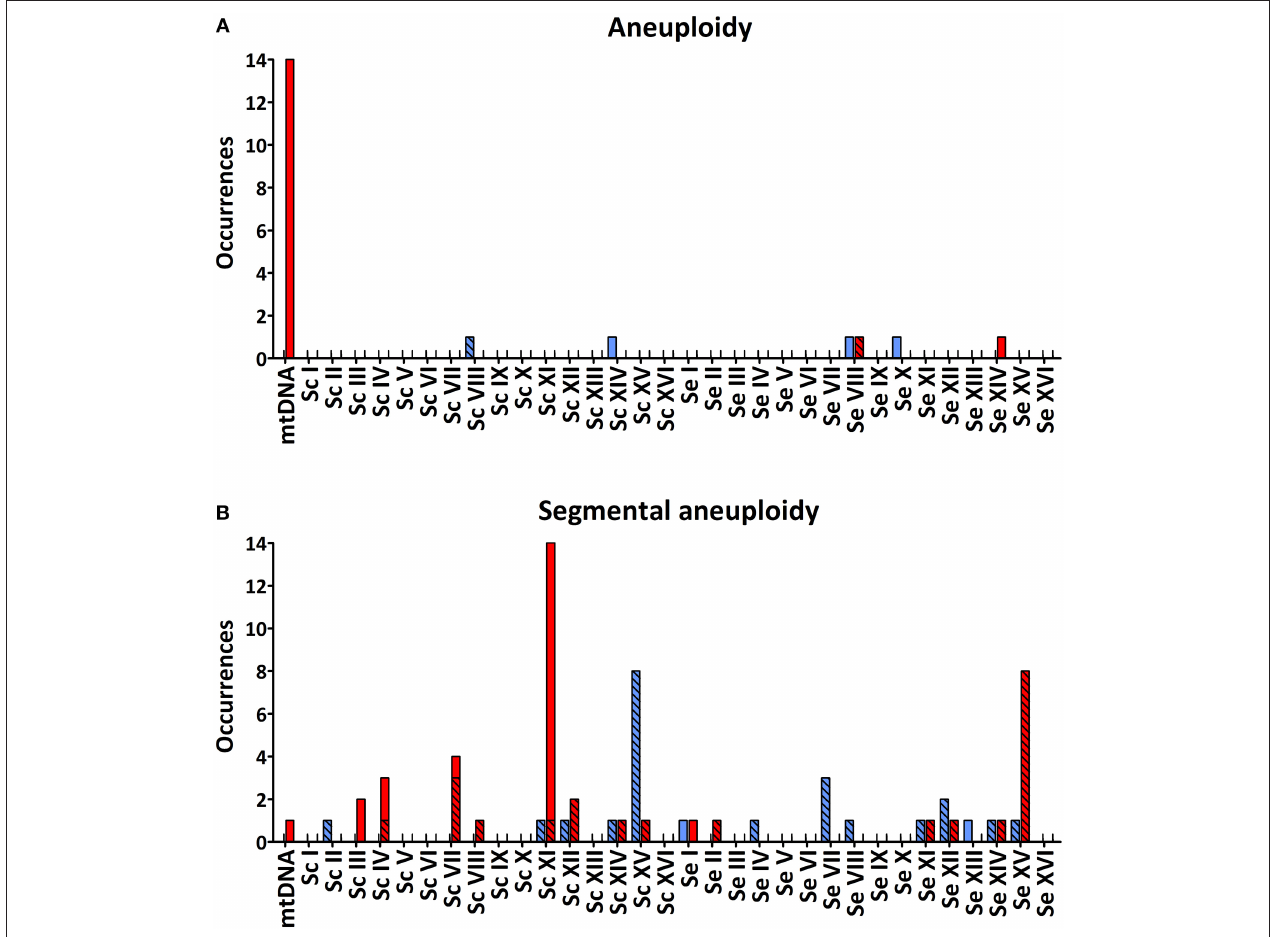
FIGURE 2 | Total number of occurrences of whole-chromosome (A) and segmental (B) aneuploidy for each chromosome of IMS0408 among 55 isolates obtained after laboratory evolution under simulated lager fermentation conditions. For each chromosome, loss of genetic material is indicated in red and duplicated genetic material is indicated in blue. Loss or duplication of S. cerevisiae or S. eubayanus genetic material which was coupled with duplication or loss of the corresponding region of the other subgenome, is indicated by checked bars. S. eubayanus harbors two translocations relative to S. cerevisiae: between chromosomes II and IV, and between chromosomes VIII and XV. For simplicity, copy number affecting these regions were allocated based on the S. cerevisiae genome